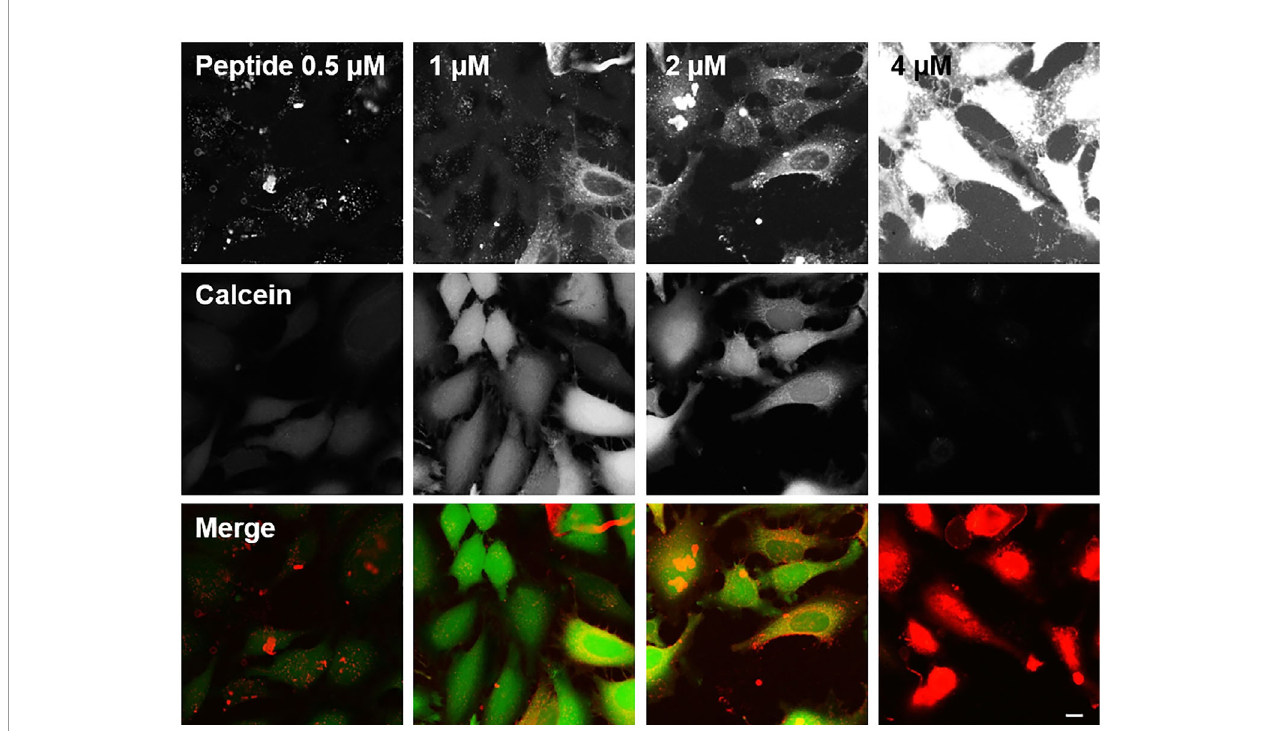
FIGURE 3 | Cell uptake of BP100 in HeLa cells. The top row shows the signal of the peptide labeled with Fluka 630 red (displayed as red channel in the merged images at the bottom). The middle row shows the signal from calcein AM, which emits a green fl uorescence when taken up by living cells (displayed as green channel in the merged images). The bottom row shows the superposition of the two channels: Overlapping red and green signals give a yellow color where BP100 has entered a living cell, while red images show cells that are permeabilized and dead. For each column the concentration of BP100 is given in the top row. Scale bar 25